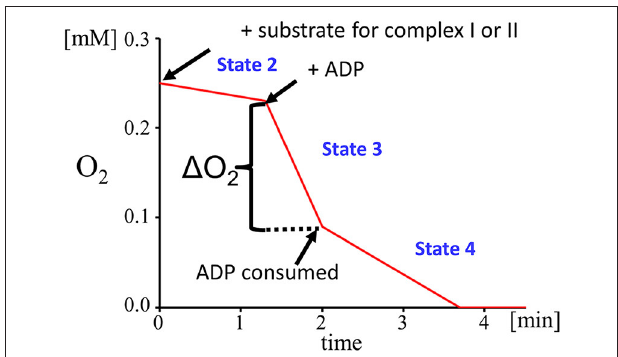
FIGURE 3 | Respiratory states: state 2 (substrate dependent respiration), state 3 (ADP dependent respiration), state 4 (steady state respiration after ADP